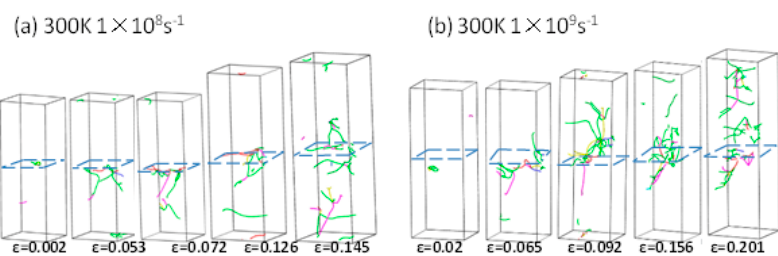
Figure 8. The DXA diagram of GBs HEAs under tensile. ( a ) 300 K, 1 × 10 8 s − 1 ; ( b ) 300 K, 1 × 10 9 s − 1.